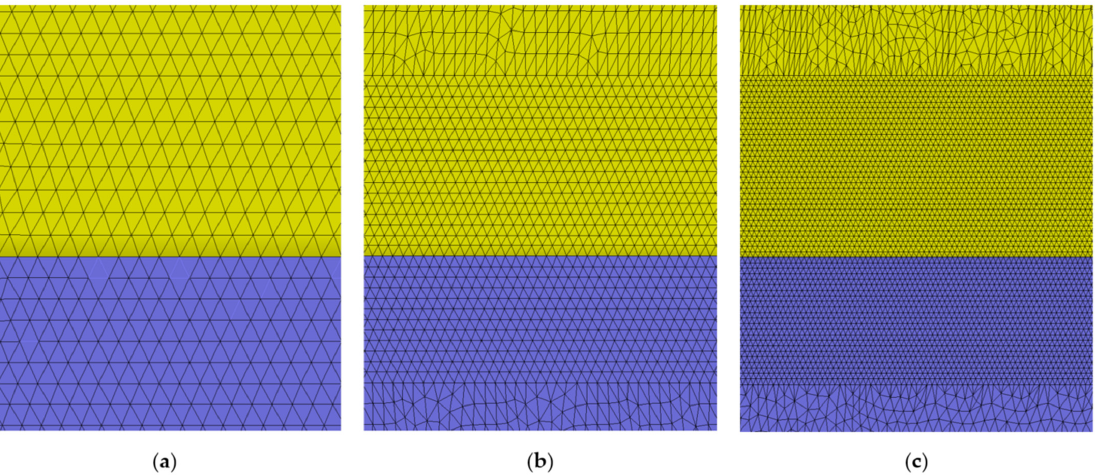
Figure 6. Three different meshes are used, where the element size close to the weld seam is varied as follows: ( a ) 1 mm (uniform mesh); ( b ) 0.5 mm; ( c ) 0.25 mm. The rest of the mesh has an element size of 1 mm in all three cases.